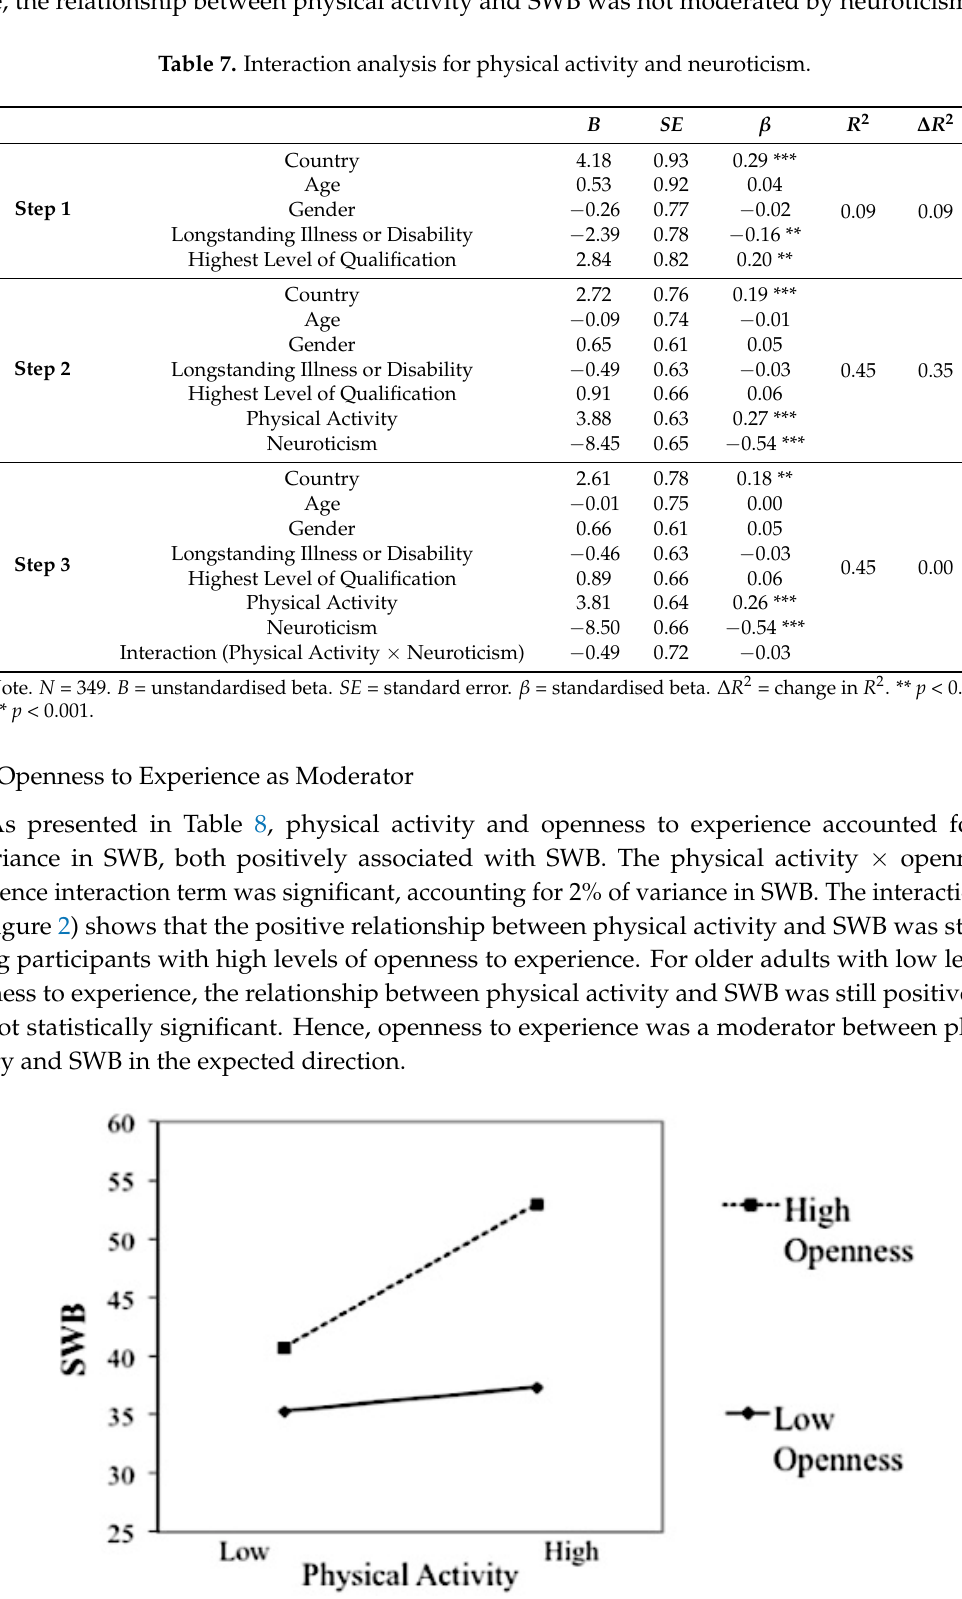
significantly lower in the HK group as compared to the UK group, namely, physical activity (mean difference = − 10.86, p < 0.001), conscientiousness (mean difference = − 2.19, p < 0.001), openness to experience (mean difference = − 2.02, p < 0.01), and SWB (mean difference = − 5.60, p < 0.001). In the multiple-group path analysis, country was set as the grouping variable, with HK and the UK allocated to a group value of 1 and a group value of 2, respectively. Age, gender, longstanding illness